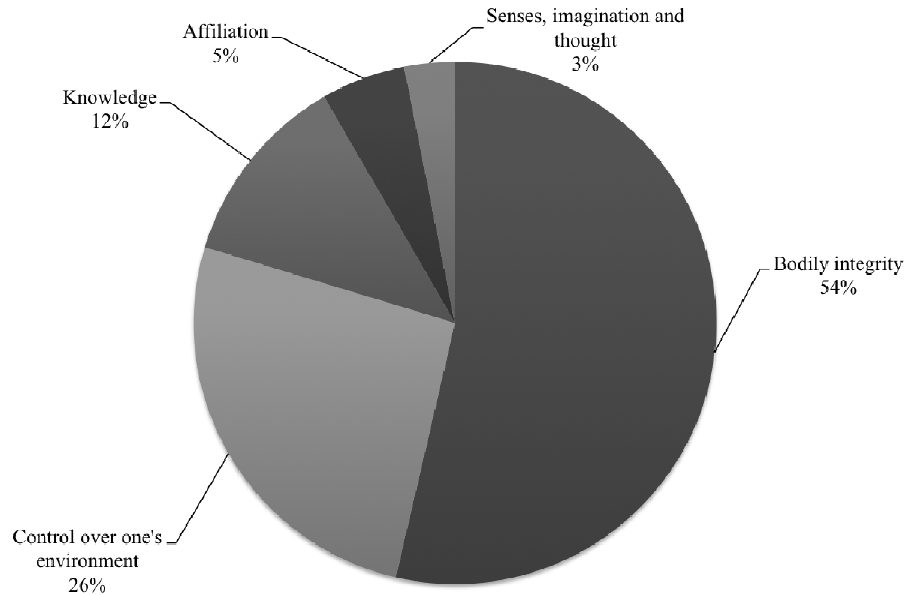
Figure 4. Data sets per capability dimension (percentages; N = 192 ).